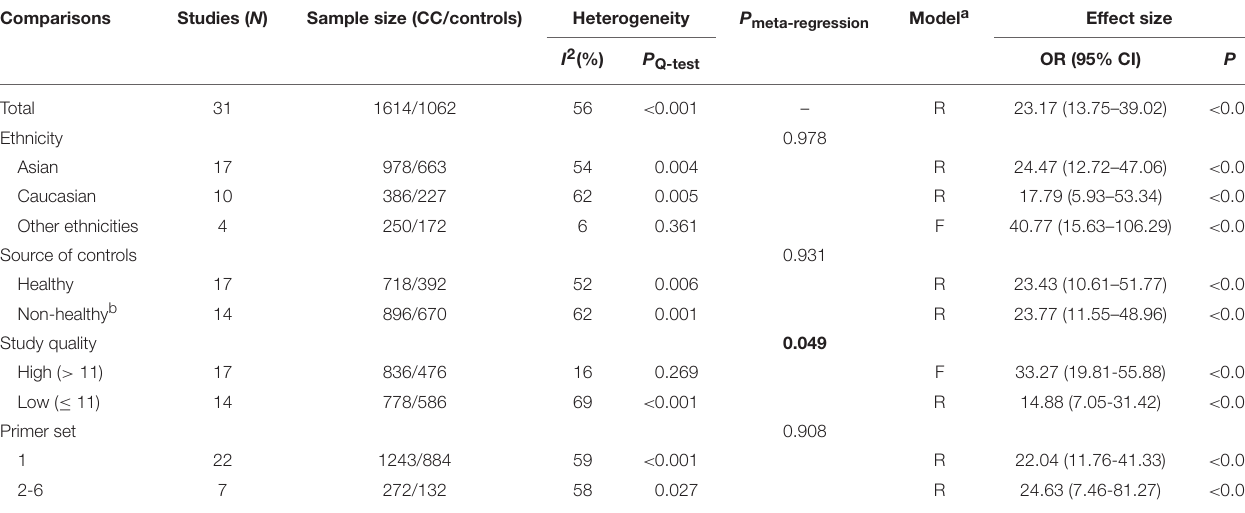
TABLE 4 | Pooled results for the association of DAPK1 promoter hypermethylation with CC risk. Comparisons